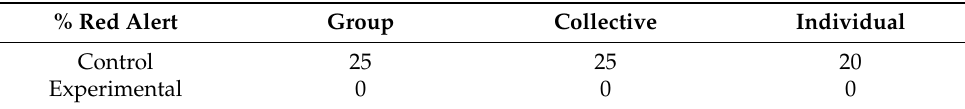
Table 12. Percentage of red level in the control and experimental groups for group, collective, and individual